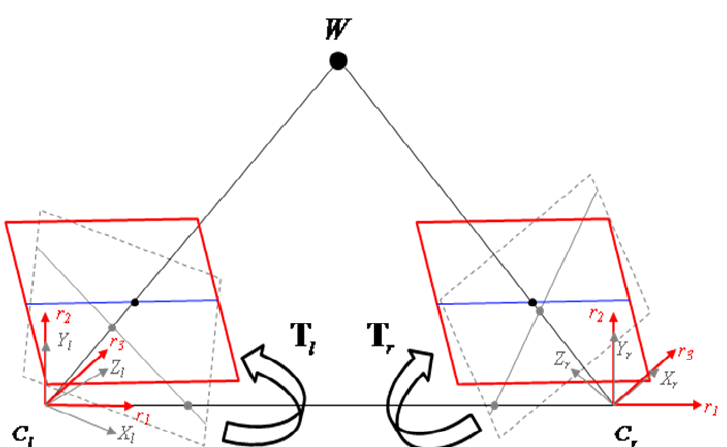
Figure 7. The epipolar